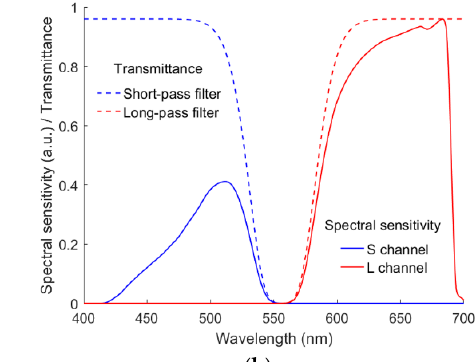
Figure 3. ( a ) Spectral transmittance of five compensation filters for camera sensors. ( b ) Spectral sen- sitivities of the yellowish green channels using the filters in ( a ). Figure 4. ( a ) Schematic diagram showing the specification definitions of the short-pass and long- pass optical filters. ( b ) Spectral sensitivity examples of the fourth channel using the short-pass and long-pass optical filters, where λ S = 528 nm and λ L = 585 nm. Refer to Section 2.1 for details. To sum up, four types of quadcolor cameras were considered, which are the RGBF, RGBC, RGBS and RGBL cameras. They are identical except for the color filter applied to the fourth channel.